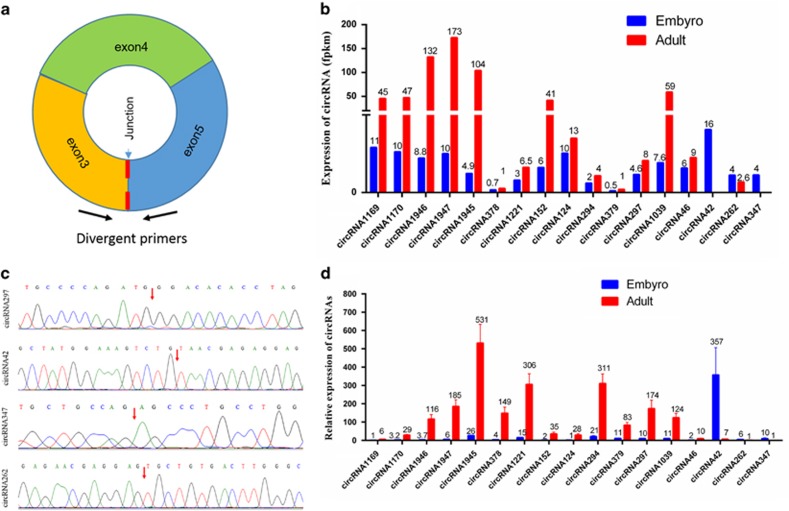
Validation of putative circular RNA by quantitative real-time PCR (qPCR). (a) Schematic view illustrating the design of primers for circRNAs used in qPCR. (b) 17 circRNAs that were selected as they exhibited significantly different expression patterns (assessed from our RNA-sequencing approach) when comparing two development stages. (c) Representative examples of PCR products purified and sequenced to confirm circRNA junction sequences. (d) Validation of differential expression of circRNAs using qPCR, whereby 17 circRNAs confirmed the predicted pattern, while two circRNAs Data are presented as means±S.E.M. for three individuals. *P<0.05